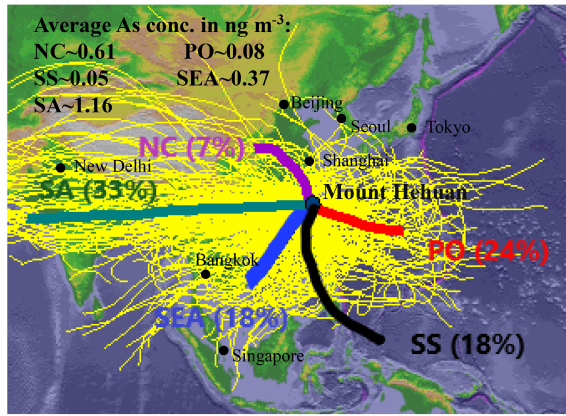
Figure 1. Clusters of backward trajectories at Mount Hehuan from September 2011 to September